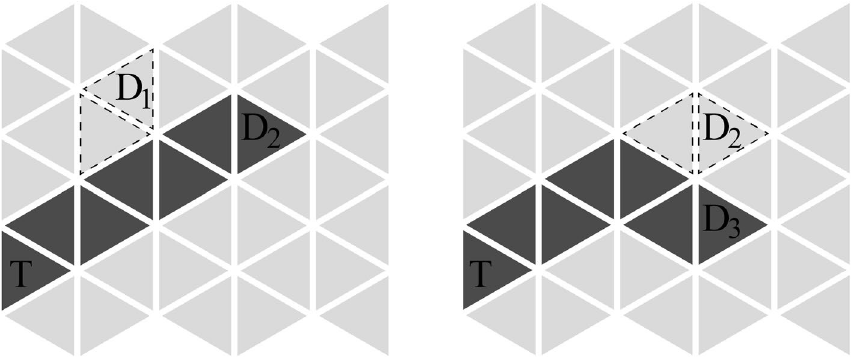
Figure 5. Optimal routes when the receiver moves from positions D 1 to D 2 and D 2 to D 3 .